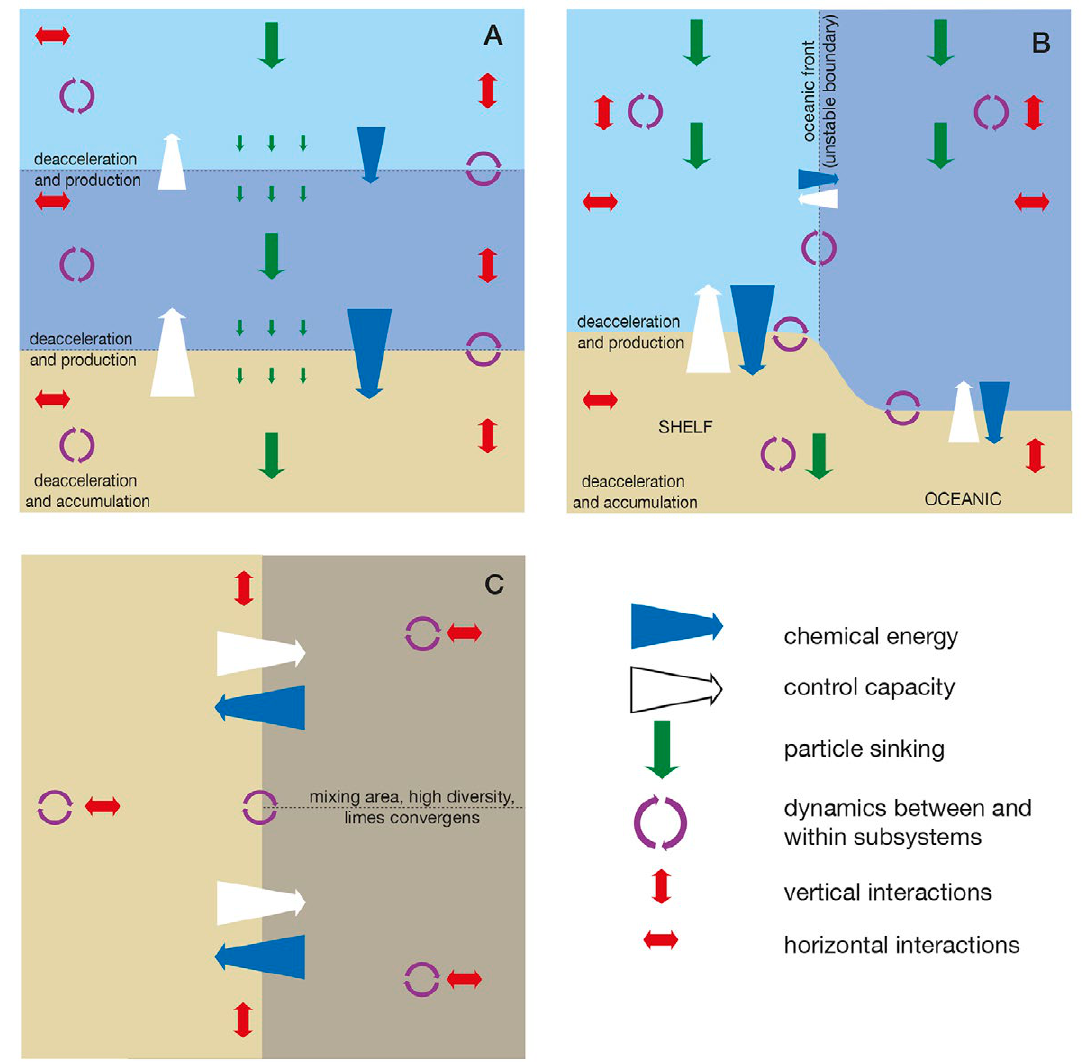
Fig. 2. – Schematic representation of interaction processes along asymmetric boundaries (reworked from Margalef 1974). The more organized subsystem receives energy from the less organized one and influences its future development. Boundaries of this type can only be stable when they are concentric (A). An intersection of boundaries is unstable (B) unless they are symmetric and passive (C), as is the case of two adjacent but different benthic communities in the same stage of maturity. Pelagic-benthic energy coupling is strong in mixed areas such as those associ- ated with pelagic fronts (B), where an increase in organic matter loading may increase subsurface dwelling and organic matter processing by benthic biomass. On continental shelves, due to their shallowness, the interactions between subsystems from the surface to the seafloor seem to be greater than in oceanic areas, where particles must go through more boundaries and thus lose energy in each transfer (B). The return of the benthos is thus expected to be greater in shelf areas. Within boundaries, deceleration of particles occurs, giving rise to production events. If the benthos is considered as a boundary, deceleration would involve an accumulation of particles, which would in turn involve a production event and thus a return of organic and inorganic matter from the benthos to the water